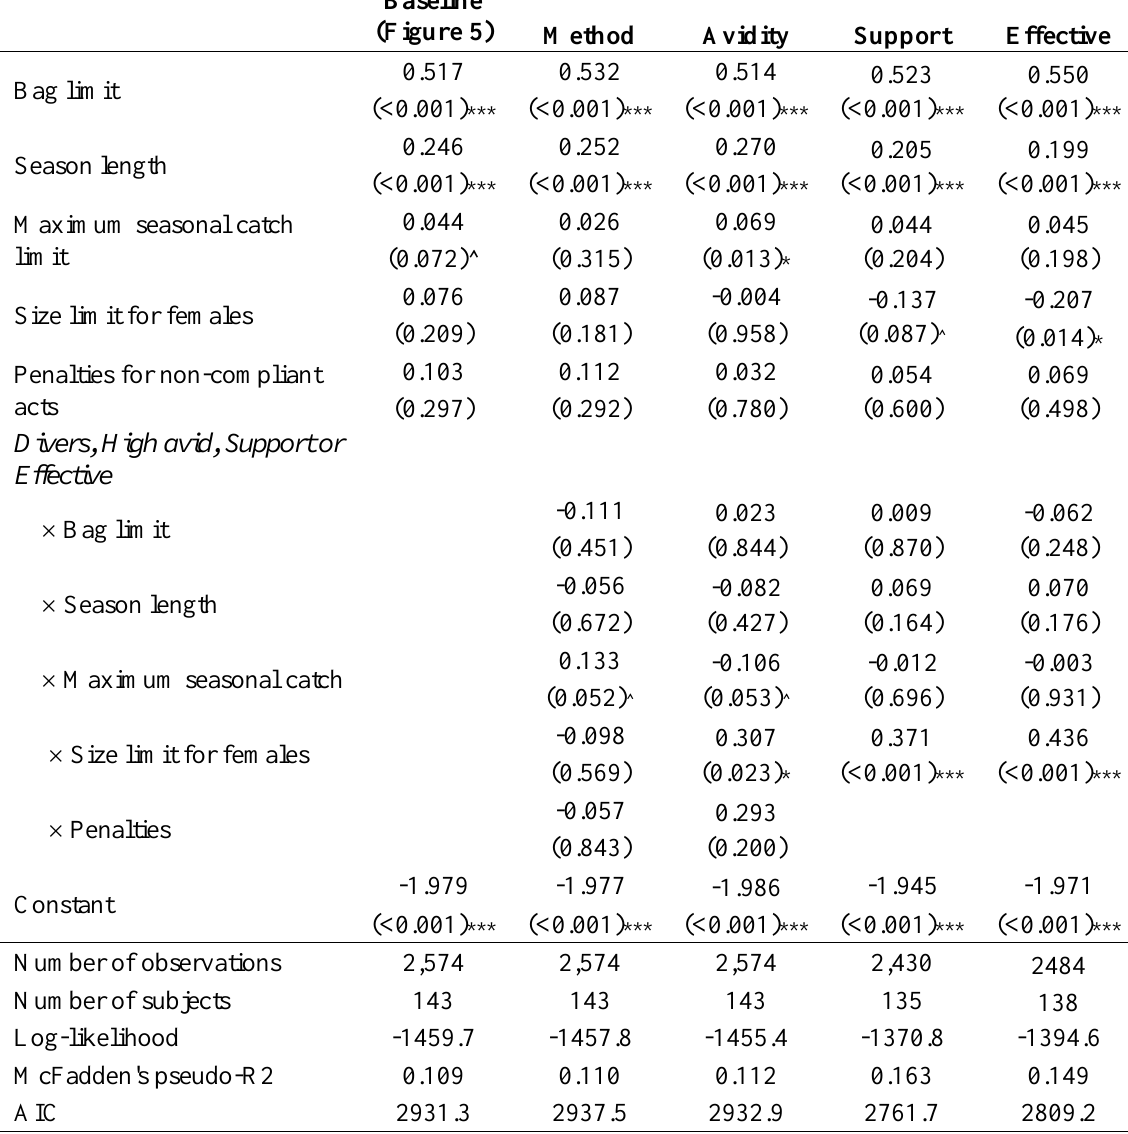
Table A.3. Sensitivity analysis: conditional logit model with interaction